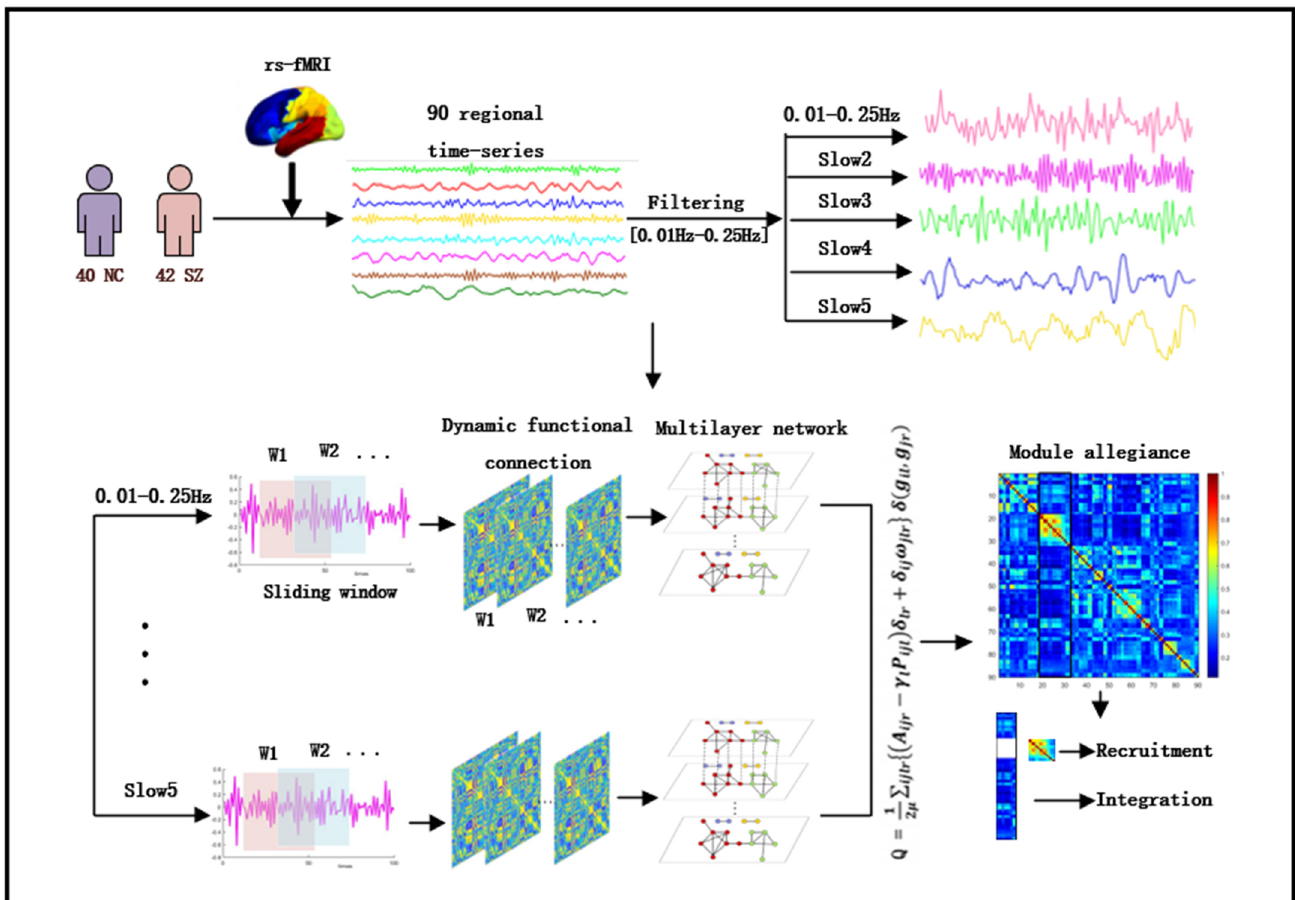
Figure 1. Schematic overview of analysis strategy. The resting-state fMRI data preprocessing results were first divided into 90 brain regions using the existing standard brain profile in the AAL template. Each brain region represented a node in the network. The brain’s physiological signals are decomposed into five frequency bands. The sliding window technique divides the time series into shorter time intervals. The functional connections within each layer are estimated using Pearson correlation. They connect the same nodes in adjacent periods and build a multilayer network for each participant. The dynamic community structure is detected by maximizing the multilayer modular quality function. We calculated the module allegiance matrix, recruitment, and integration to analyze the difference between NC and SZ. Table 1. Demographic and clinical